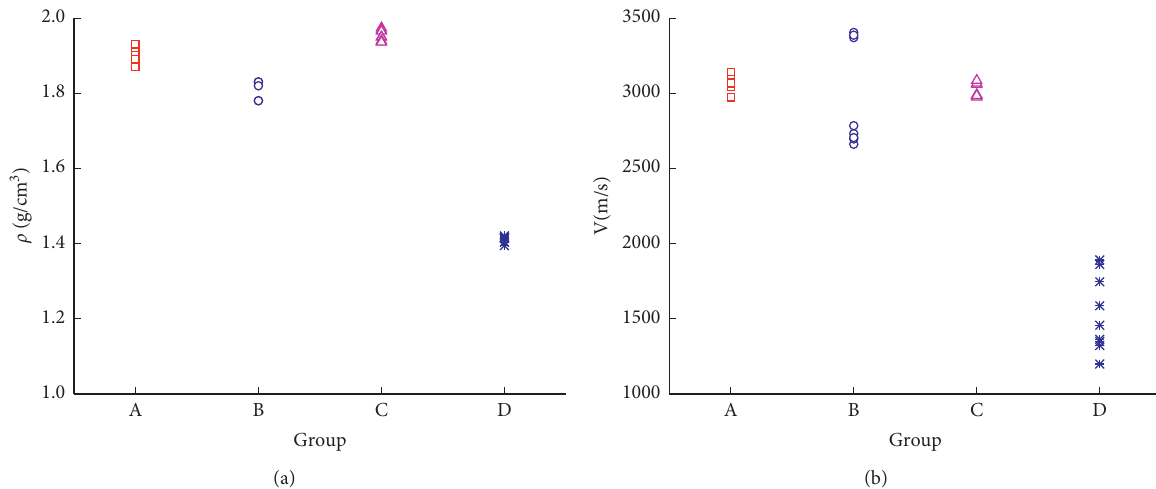
Figure 5: Density and longitudinal wave velocity of each group of samples. (a) Density. (b) Longitudinal wave